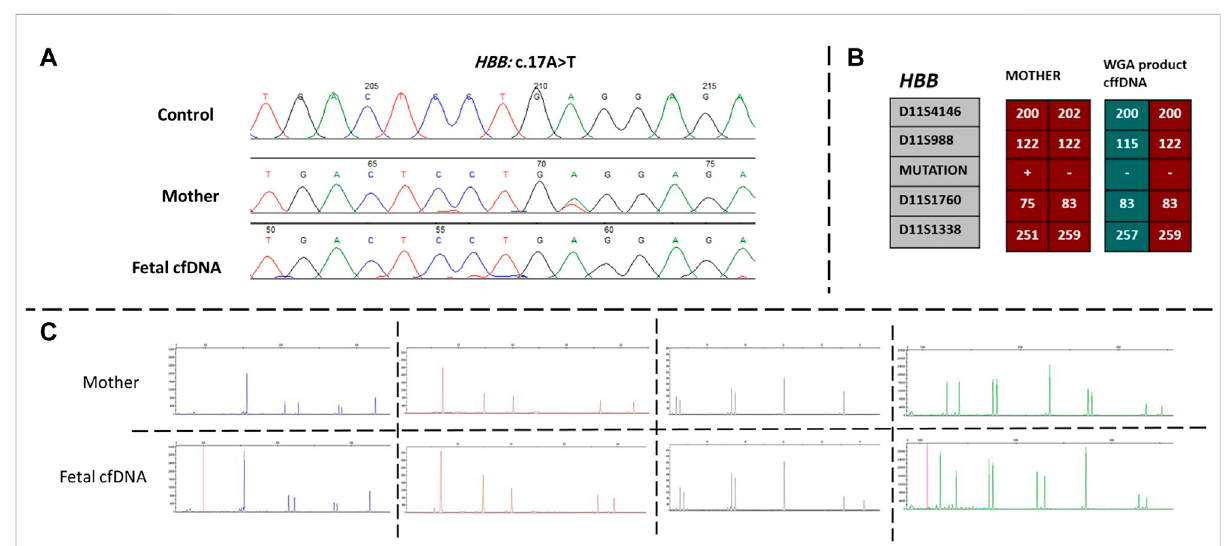
FIGURE 2 Findings of case 2. (A) Sanger results for HBB gene for mother and WGA product of cffDNA. (B) Karyomaps comparison for HBB , gene between themotherandWGAproductofcffDNAtodetectthepaternalalleleandexcludeADOprobability. (C) AmpFLSTR ™ Identi fi ler ™